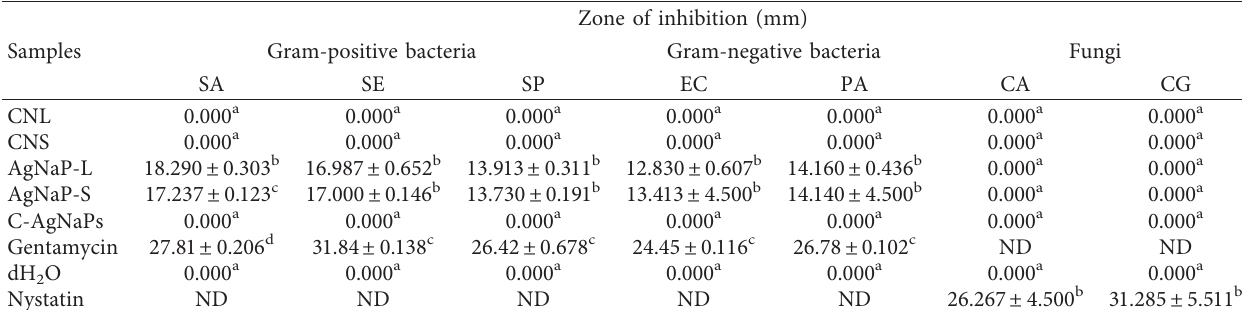
ND � not determined. Table 2: Inhibition zones (mm) of the biosynthesised silver nanoparticles against tested microorganisms using the well diffusion method (mean ± SD, n � 3); mean values are significantly different ( p < 0.05) between tested samples in each particular bacterium/fungus with different lower case superscript letters a, b, c, and d.